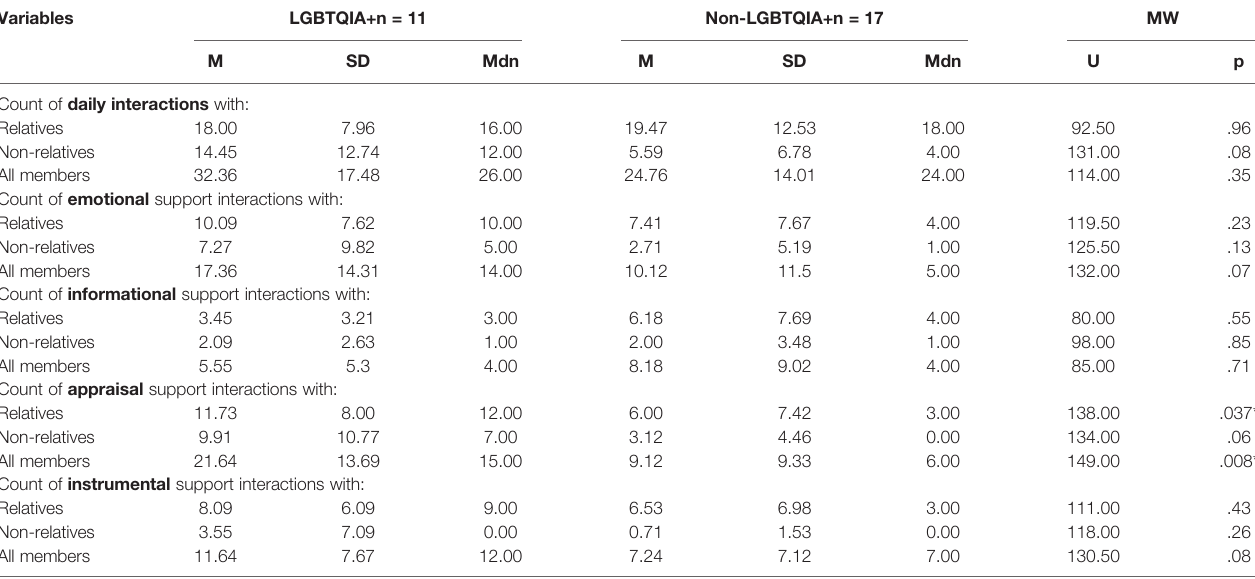
TABLE 3 | LGBTQIA+ and non-LGBTQIA+ support interactions with relatives and non-relatives.